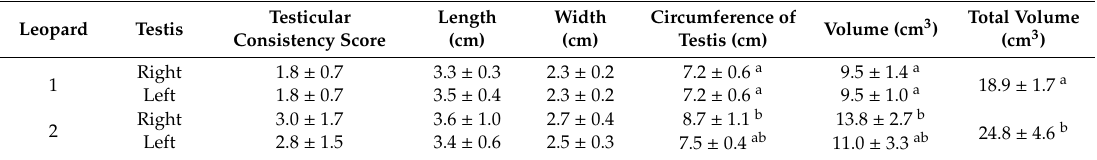
Table 2. Mean (± standard deviation) of length, width, and volume of right–left testes and total testicular volume of two Sunda clouded leopards living singly.